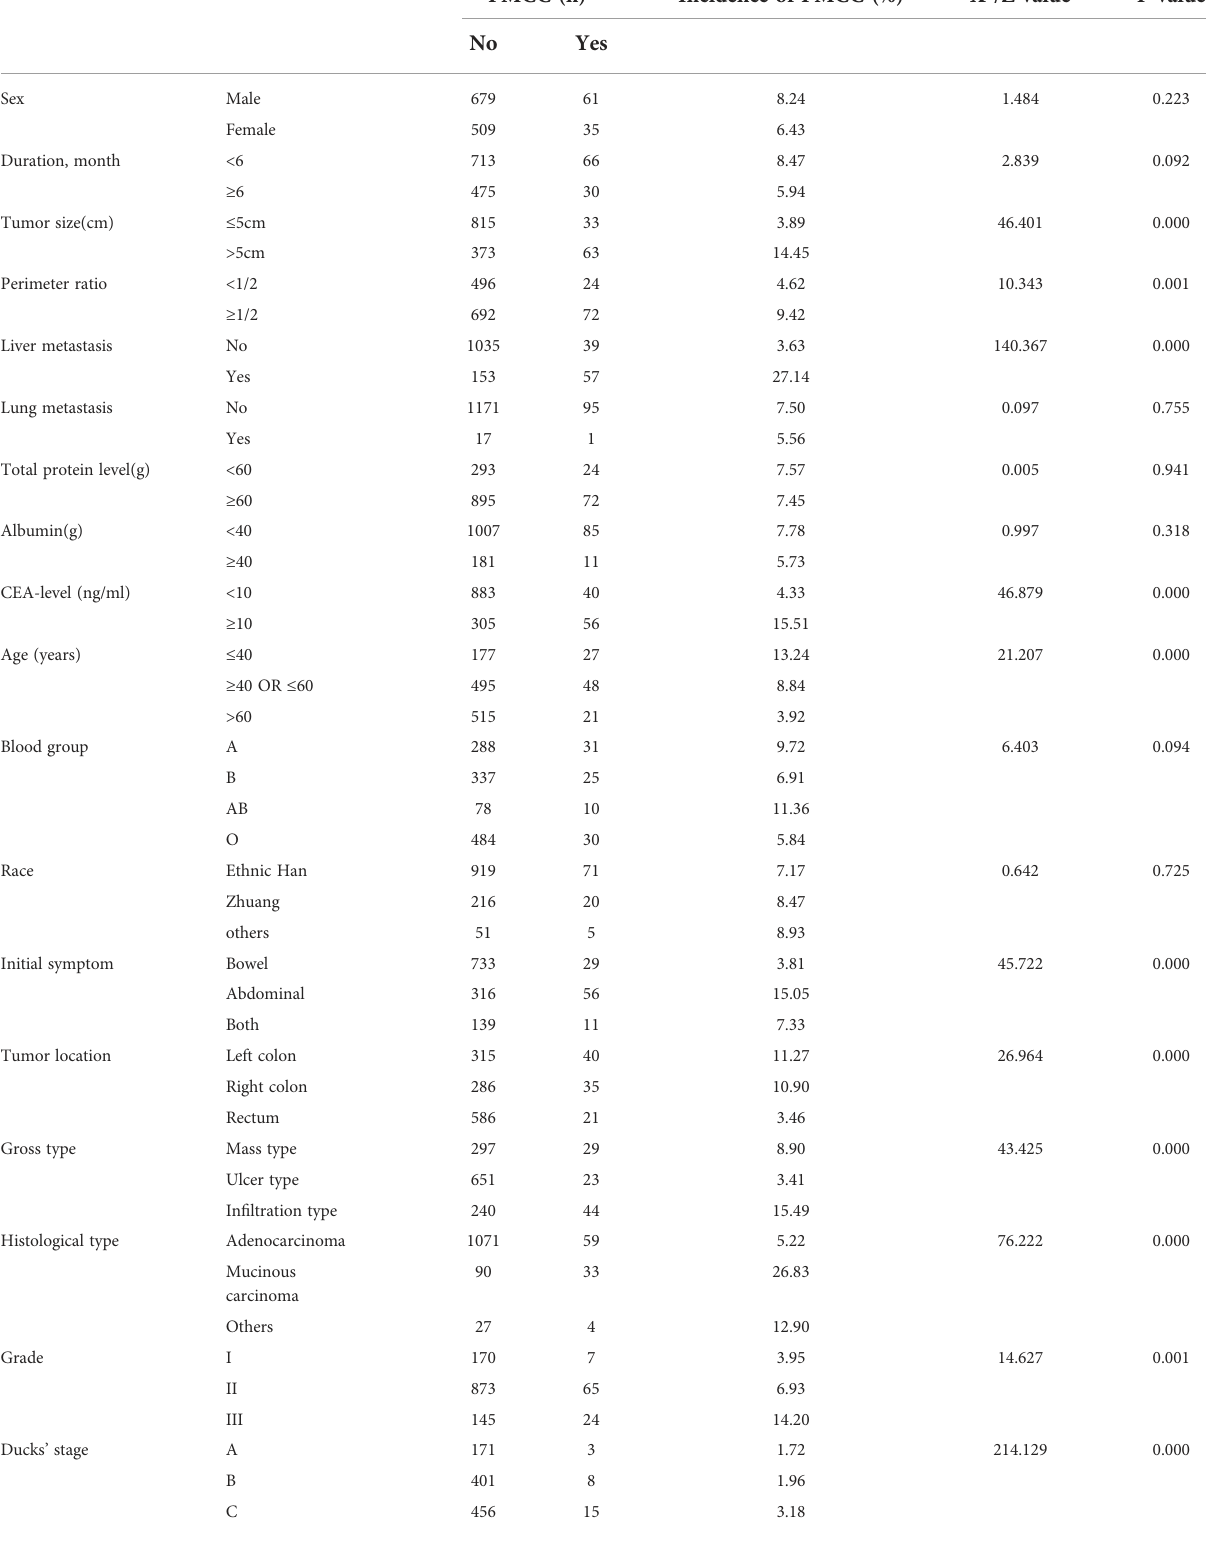
TABLE 1 Characteristics of patients included in this